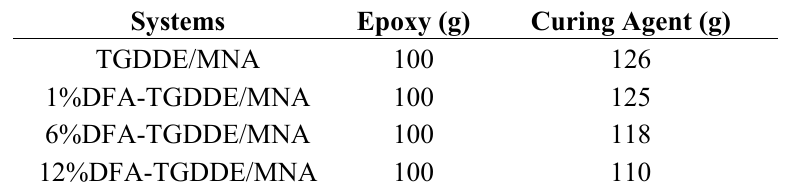
Table 5. The formula of TGDDE/MNA and DFA-TGDDE/MNA